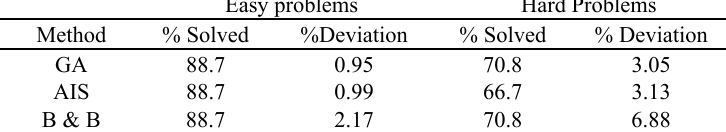
Table 5. Performances of three methods Easy problems Hard Problems